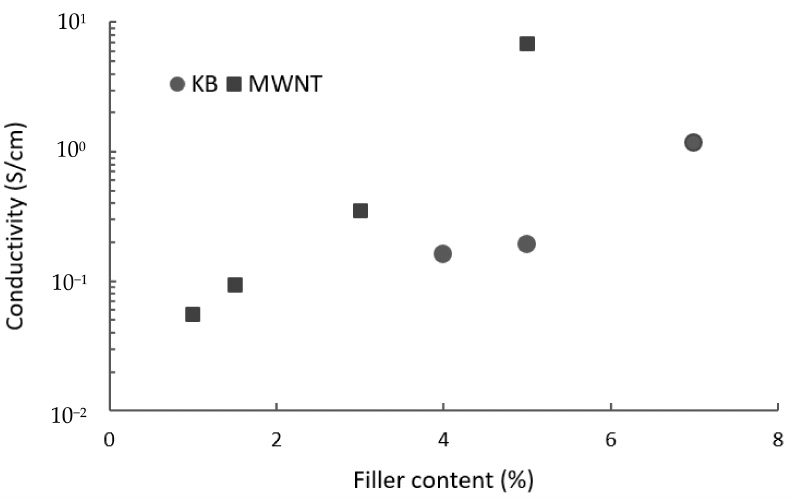
Figure 2. Electrical conductivity as a function of the filler content for 3D-printed layers of PLA nanocomposites containing MWNT and KB.